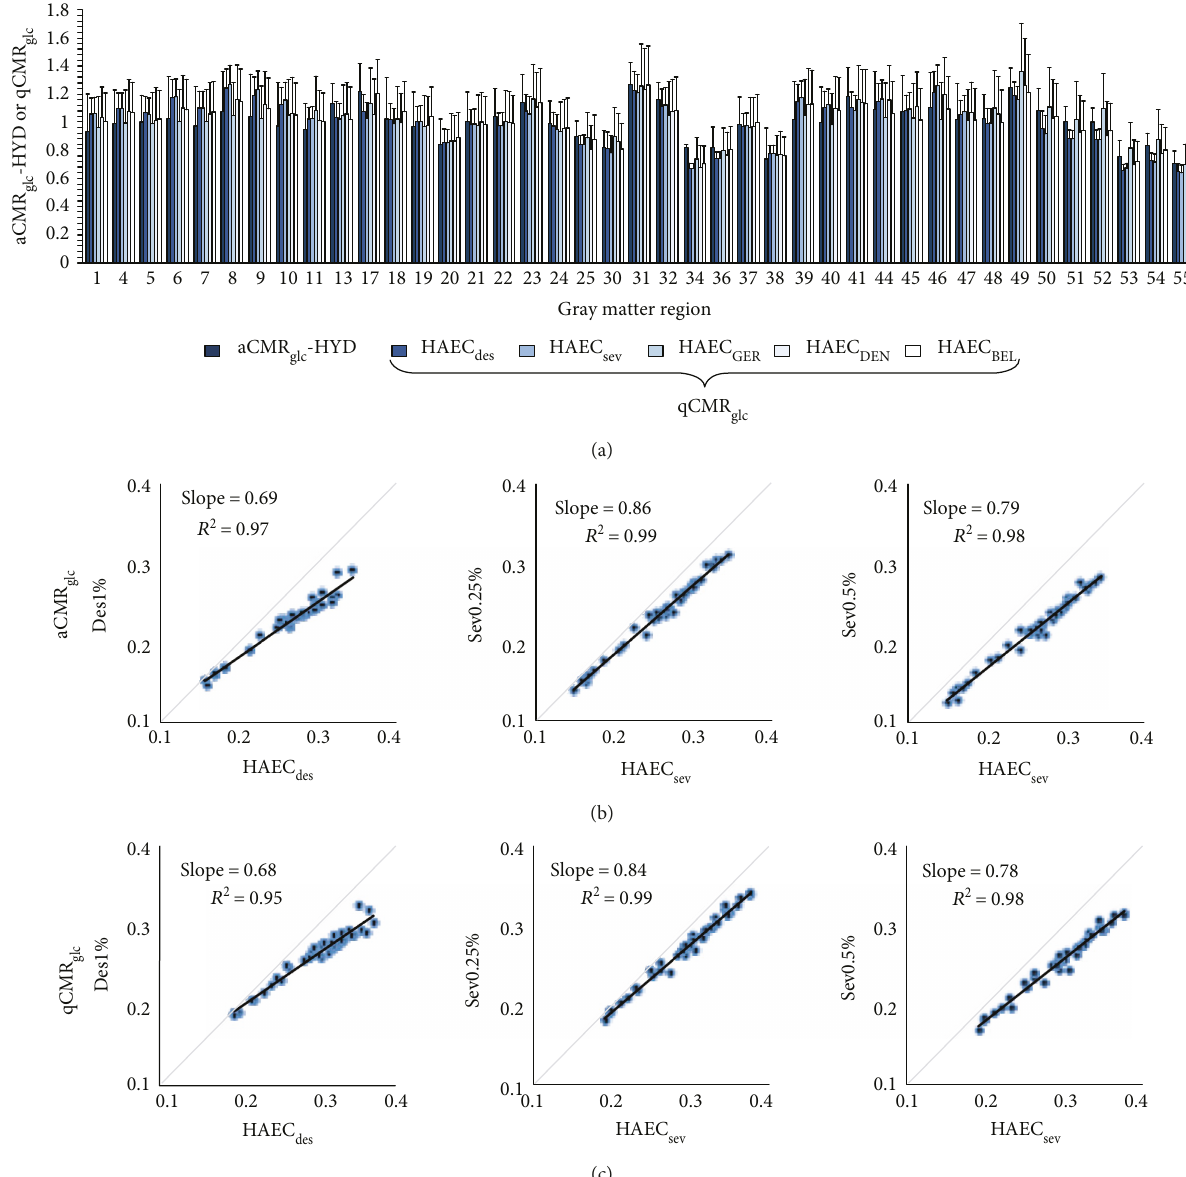
Figure 1: Validation of quanti fi ed CMR (qCMR ). (a) Comparison of absolute CMR from Hyder et al. [36] (aCMR -HYD) with glc glc glc glc qCMR from fi ve sites for the HAEC condition (Table 1). Bars represent the mean across all subjects in each group for gray matter glc regions (Table S1), where error bars are one standard deviation. All qCMR and aCMR -HYD values were very similar both relatively glc glc between regions and in terms of mean value, suggesting across-site comparisons are possible with our procedure for quanti fi ed CMR . glc for the HAEC group The Pearson correlation and the Euclidean distance (Table 2) suggest high similarity and low di ff erence of CMR glc across all sites. (b) Scatter plots, from left to right, for aCMR between Des1%, Sev0.25%, or Sev0.5% groups and equivalent HAEC glc groups (Table 1). Each point is one gray matter region (Table S1). Slope and R 2 from a linear fi t are shown, and units are μ mol/g/min, where a slope of less than 1 corresponds to a lower CMR in the anesthetized group compared to the control. (c) Same as in (b), except glc using qCMR from each group. The slopes are almost identical in (b) and (c), indicating that the calculation of qCMR does not alter glc glc the relationship between groups for aCMR glc